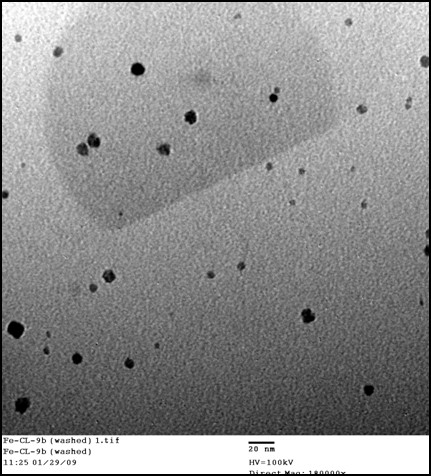
TEM image of Fe/Fe3O4 core/shell nanoparticles featuring an organic protective dopamine-anchored stealth layer.